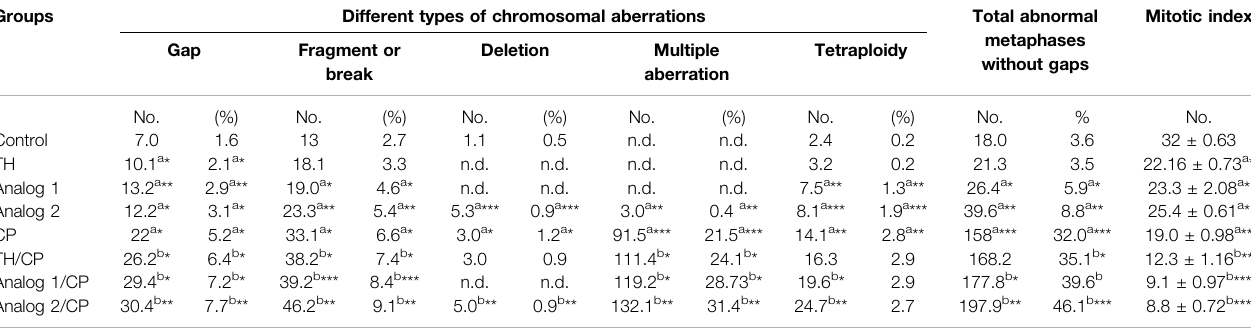
TABLE 1| Chromosomal aberrations and mitotic index analyses: BMCs from different mice groups have been investigated after 24 h from administration ofTHand analogs in absence and presence of CP.